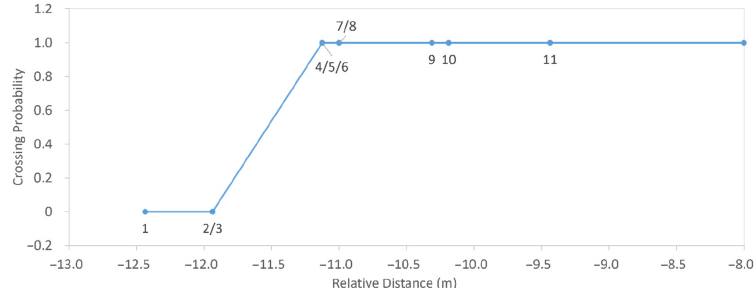
Figure 11. Pedestrian crossing intention prediction with longitudinal relative distance between pe- destrian and vehicle.